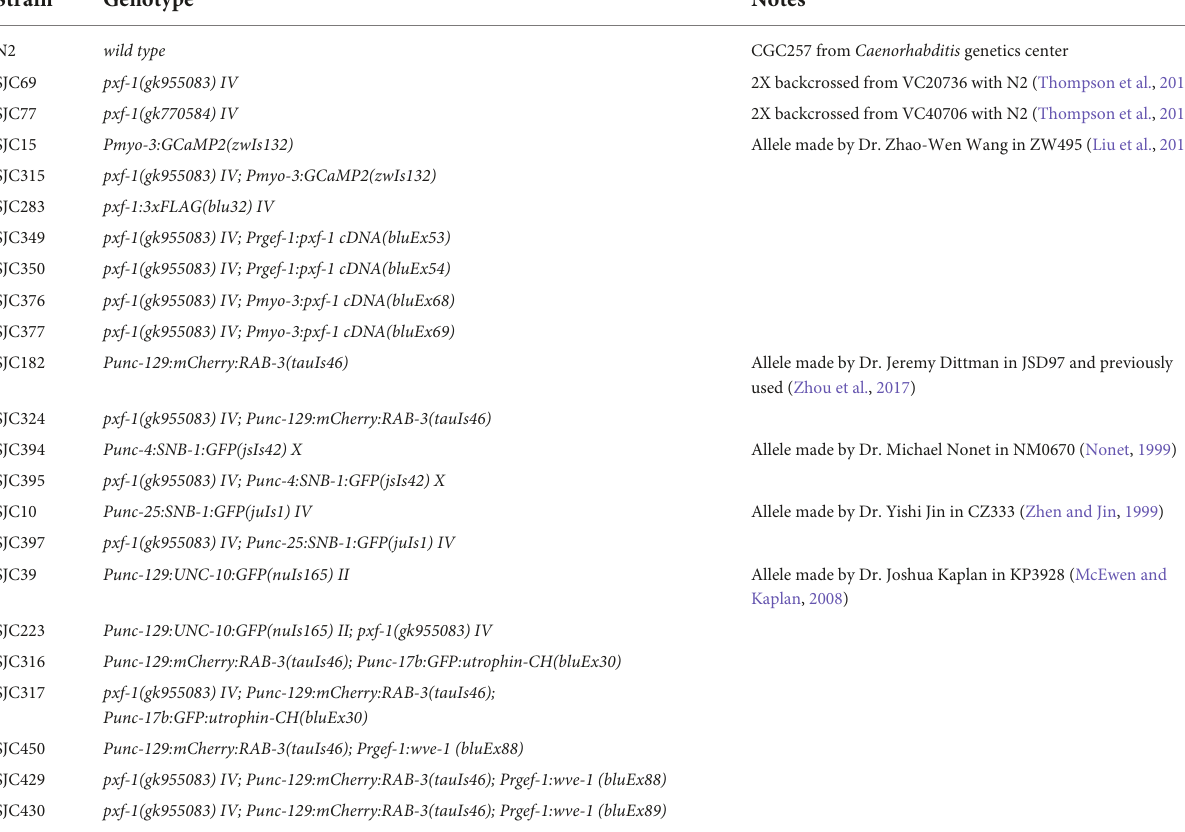
TABLE 1 Details and genotypes for the strains used in this